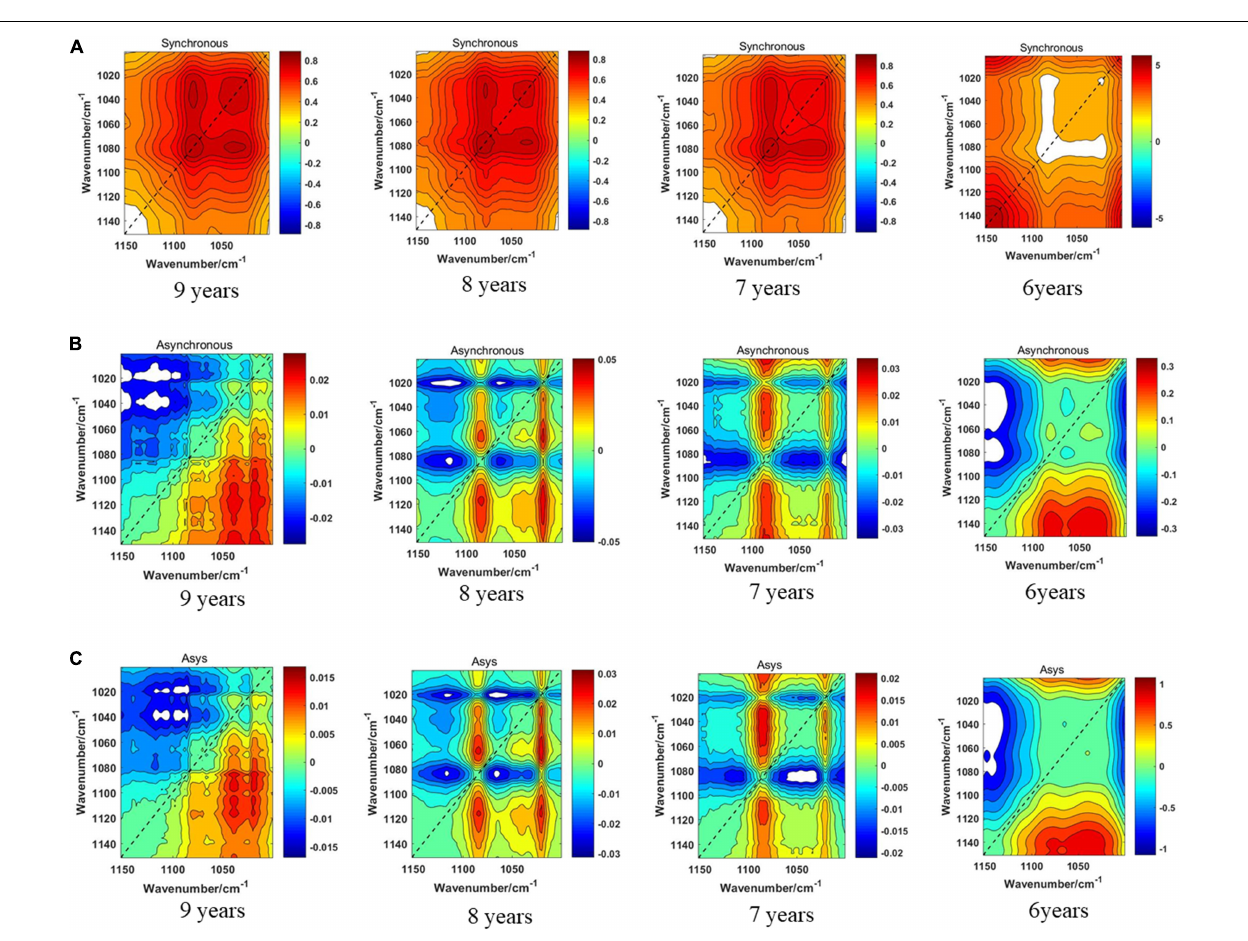
FIGURE 11 | (A) The synchronous 2DCOS spectra of the 1,150–1,000-cm − 1 band. (B) The asynchronous 2DCOS of the 1,150–1,000-cm − 1 band. (C) The i2DCOS spectra of the 1,150–1,000-cm − 1